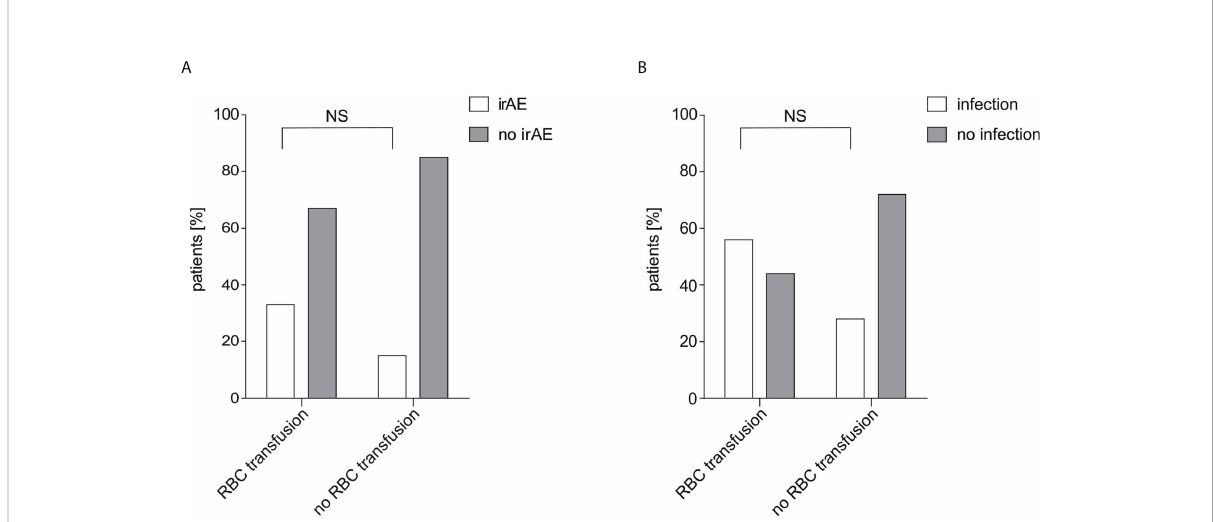
FIGURE 2 IrAE and infection rate in relation to RBC transfusions. (A) The irAE rate depending on received RBC transfusions within 60 days after start of IT is shown. Of 40 patients in the non-transfused group 6 patients (15.0%) showed an irAE while of 15 patients in the transfused group 5 patients (33.3%) showed an irAE. The difference was calculated using Fisher ’ s exact test (p=0.149). (B) The infection rate depending on received RBC transfusions within 30 days before start of IT is shown. Of 46 patients in the non-transfused group 13 patients (28.3%) were treated with antibiotic treatment, while of 9 patients in the transfused group 5 patients (55.6%). The difference was calculated using Fisher ’ s exact test (p=0.135). RBC, red blood cell; irAE, immune-related adverse events; NS, not signi fi